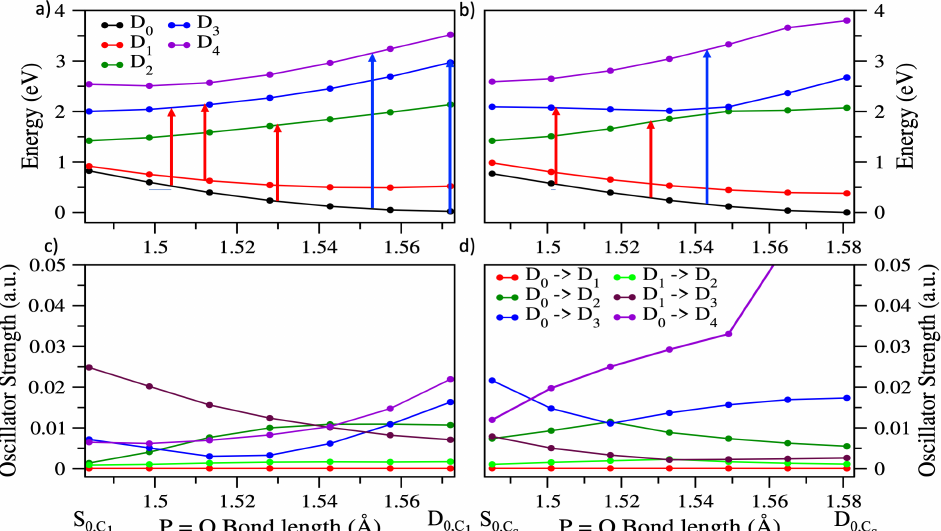
Figure 5. Energies along LIIC connecting vertical ionization to the minimum of the cation for ( a ) the asymmetric conformer, connecting the neutral minimum geometry, (S 0,C ) to the cation min- 1 imum geometry (D 0,C ); ( b ) the symmetric conformer, connecting the neutral minimum geome- 1 try (S 0,C ) to the cation minimum geometry (D 0,C ). The transitions due to probe light of 400 nm s s (3.1 eV) and 800 nm (1.6 eV) are represented with blue and red arrows respectively. ( c , d ) Oscilla- tor strengths along the paths shown in ( a , b ), respectively. The vertical energies were calculated at the EOM-IP-CCSD/6-311+G(d) level of theory. The oscillator strengths were calculated at the 7SA-CASSCF(13,9)/6-311+G(d) level of